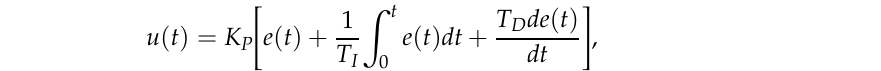
Table 8. PID (proportional integral derivative) values under di ff erent working conditions.